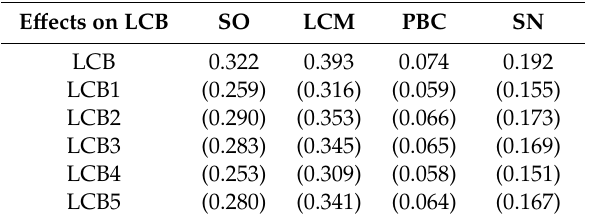
Table 14. E ff ects of factors on low-carbon behavior of sta ff in hotels (LCB) in the final model. E ff ects on